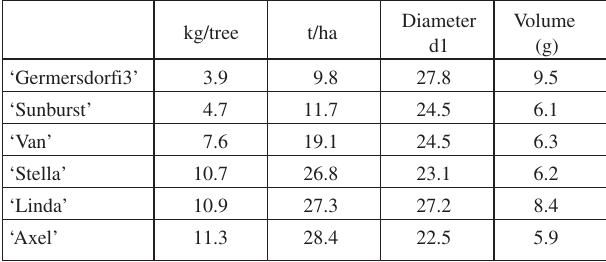
050100150200250 Figure3: Number of fruits per current meter on the branches of different age in cherry varieties (Debrecen-Pallag, 2009) 050100 Figure 4: Fruits set per flowers (K%) on fruiting parts of different age in cherry varieties (Debrecen-Pallag, 2009)